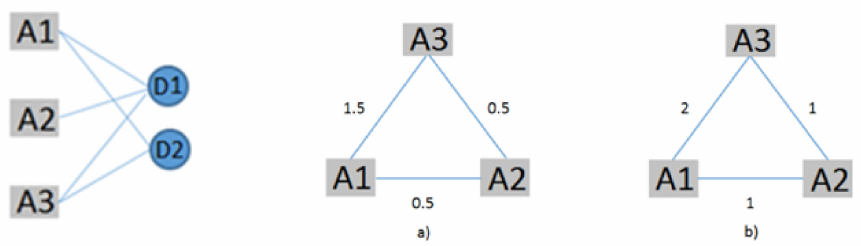
Figure 3. Bibliographic coupling network of authors, ( a ) fractional counting method, ( b ) full counting